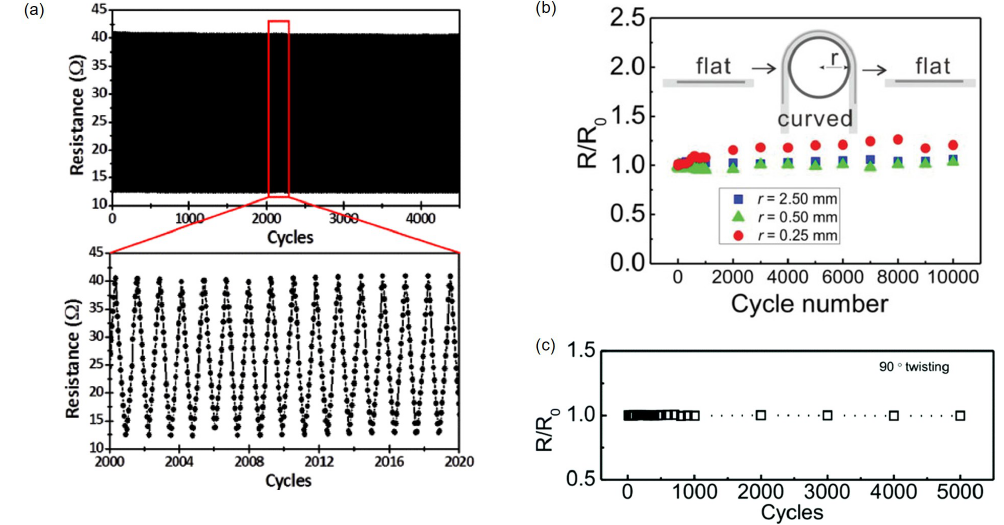
Figure 11. ( a ) Resistance measurement of the liquid metal strain gauge for 4500 cycles at (cid:101) = 350%. The zoom-in shows ∼ 20 cycles. There is no noticeable degradation. © [2015] IEEE. Reprinted, with permission, from [50]. ( b ) Normalized resistance measurement of patterned galinstan resistors for 10,000 bending cycles at bending radii of 0.25, 0.5, and 2.5 mm. Reproduced with permission from [71]; published by John Wiley and Sons, 2019. ( c ) Normalized resistance measurement of patterned EGaIn resistors for 10,000 twisting cycles at twisting angle of 90 ◦ . Reproduced from Ref. [44] with permission from the Royal Society of